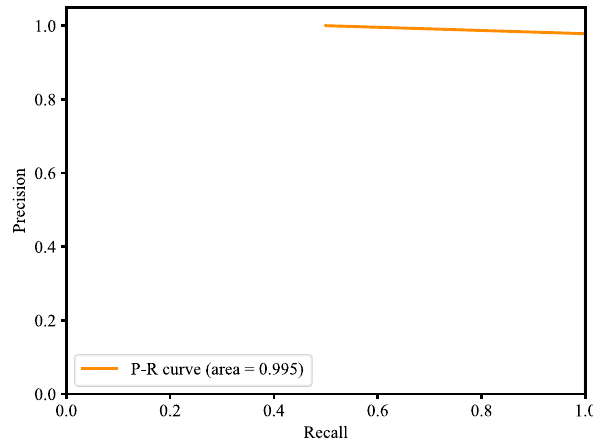
Figure 33. P-R curve of mask wearing detection.